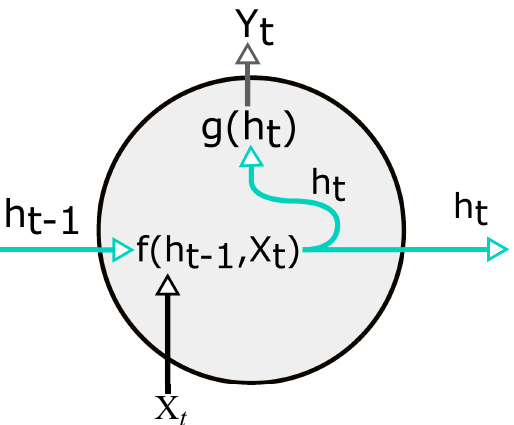
Figure 5. RNN cell. Array X and array Y represent the input and output of the network; h indicates the hidden units of the network; t represents the time